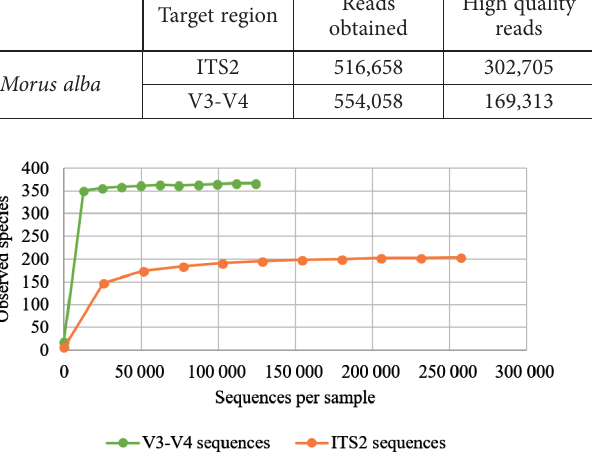
Figure 1. Rarefaction curves describing M. alba fruit-associated species richness at a genetic distance of 3% for each sample. ITS2 sequences from the analysis of eukaryotic microbial community and V3-V4 region sequences from the analysis of prokaryotic microbial community